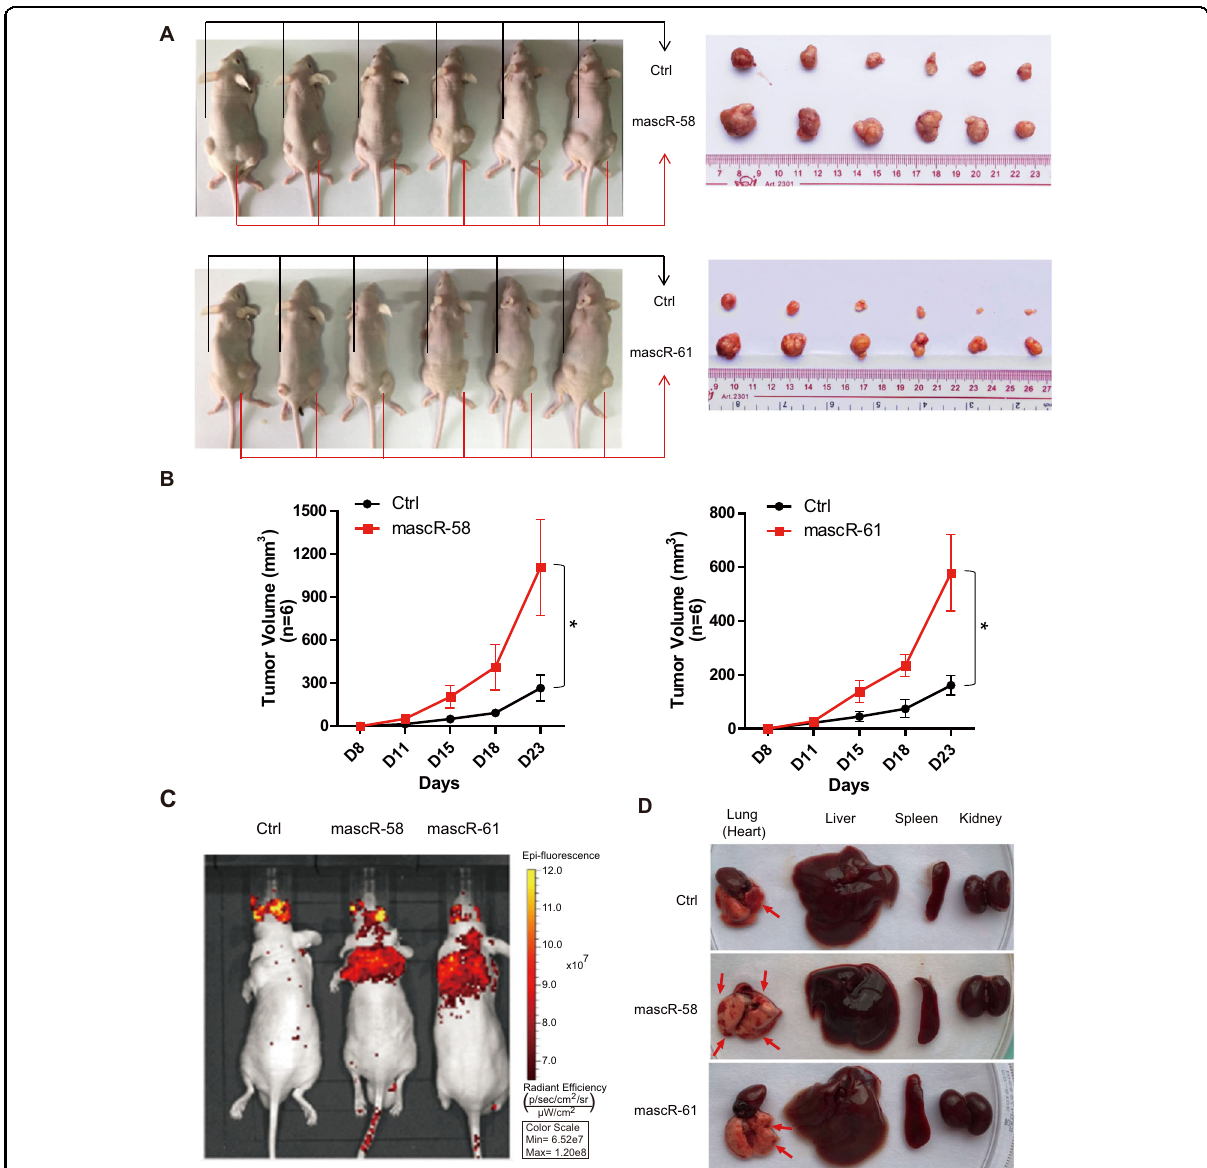
Fig. 3 mascRNA promotes HCC tumor growth and metastasis in vivo. A Subcutaneous tumor formation in male BALB/c-nu mice. mascR-58nt or mascR-61nt overexpressed Bel7402 stable cells were injected subcutaneous on the right side of mice, while the same number of corresponding control cells were injected on the left side of the same mice. After 4 weeks, the mice were dissected, and the tumors grown under the skin were removed, measured, and photographed. B The tumor volumes were measured on day 8, 11, 15, 18, and 23 after subcutaneous injection. n = 6/group. C In vivo metastasis assay of Bel7402 stable cells was performed by tail intravenous injection. Representative images of mice with the scramble control (Ctrl), mascR-58nt and mascR-61nt overexpression constructs were taken by the in vivo animal imaging system. The bioluminescence signals indicated the location of cancer cells. D Mice after the bioluminescence signal detection were sacri fi ced and dissected. Lung (heart), liver, spleen, and kidney were excised and the surface changes of organs were observed. Lesions in lung are indicated by red arrows. Quantitative data were represented as mean ± SD. * P <